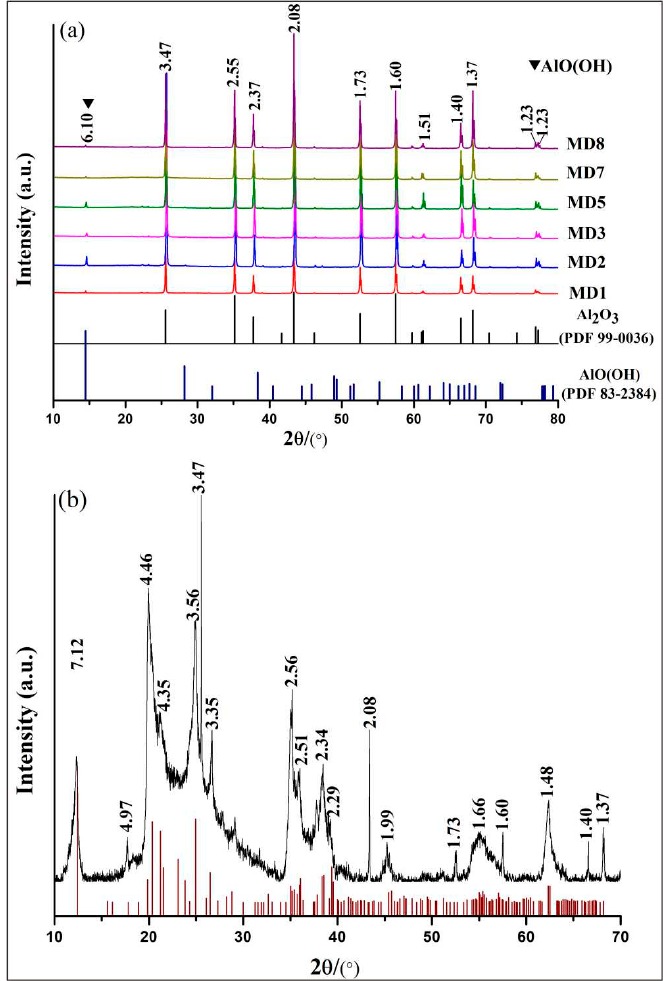
Figure 4. ( a ) Representative XRD diffraction pattern of white powder on sapphire and rough surface. ( b ) Off-white material on the surface of the rough sample.